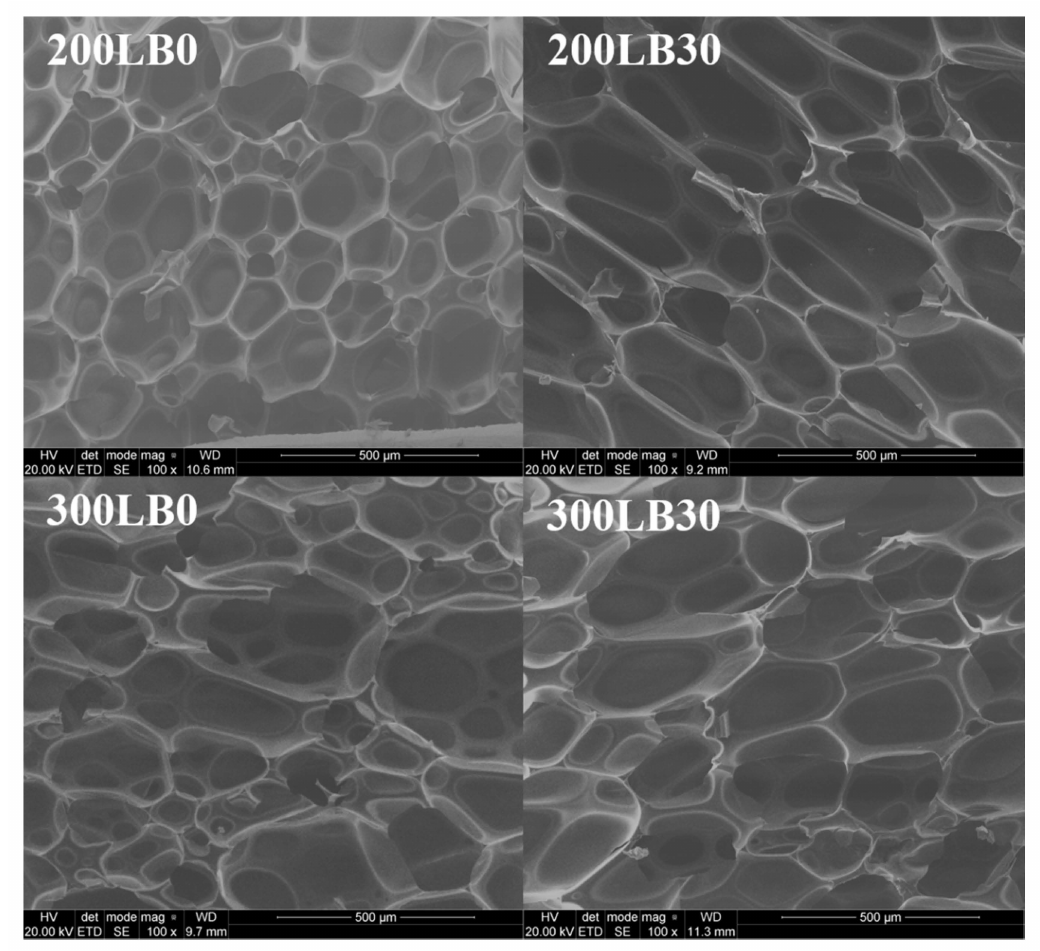
Figure 9. SEM of rigid polyurethane